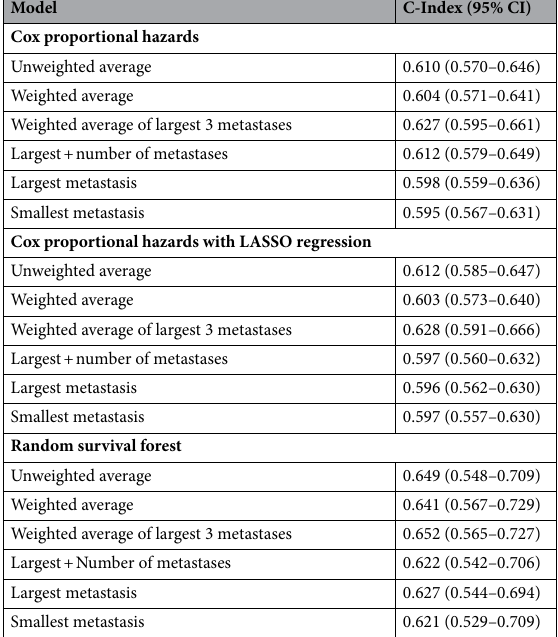
Table 2. Comparison of aggregation methods.